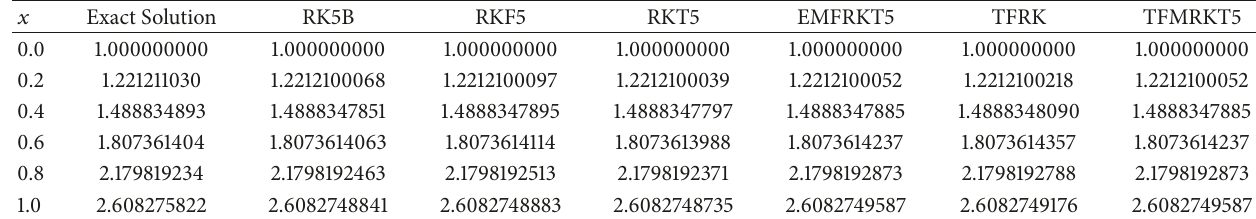
Table 2: Numerical results for problem in Thin Film Flow (58) taking ℎ = 0.1 and 𝑘 = 2 .